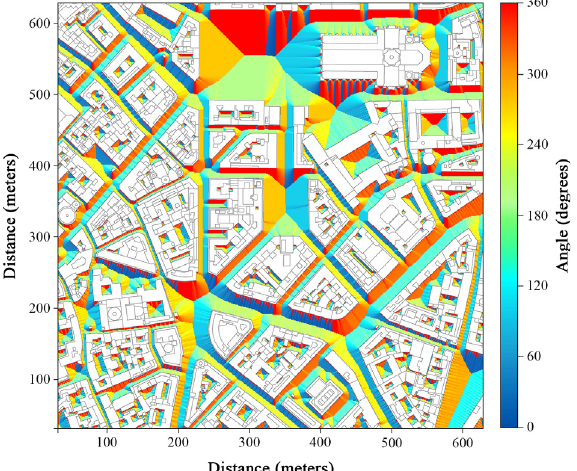
Figure 4. Patterns of wind obstruction based on the angle Maximum obstruction ( α = 0°); (b) High obstruction ( α ≈ 23°); (c) Medium obstruction ( α ≈ 45°); (d) Channeling ( α =